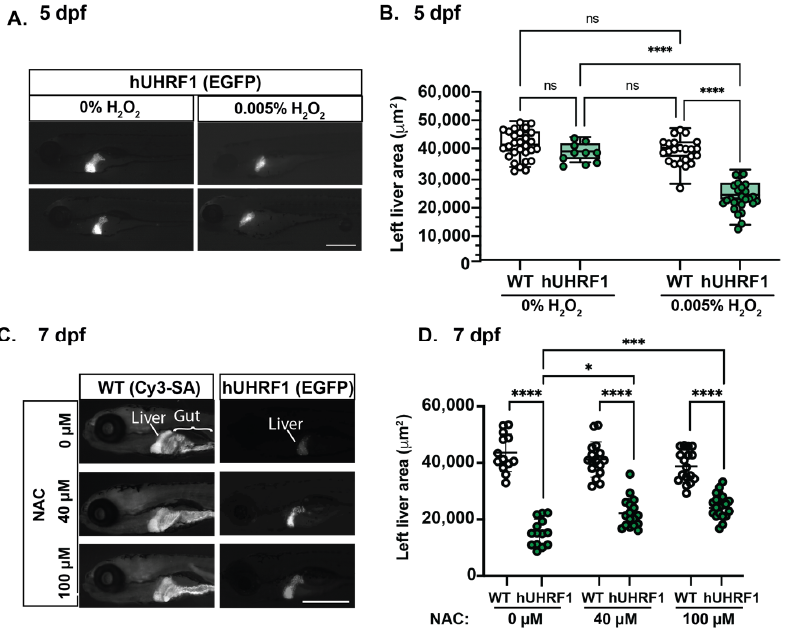
Figure 6. The small liver phenotype caused by hUHRF1 overexpression is enhanced by H 2 O 2 exposure and reversed by NAC treatment. ( A ) hUHRF1 transgenic larvae and their non-transgenic siblings were untreated or treated with 0.005% H 2 O 2 for 40–42 h and collected at 120 hpf. The left liver area was measured using the EGFP fluorescence (hUHRF1 transgenics) or CY3-SA staining (WT). ( B ) Left liver lobe area is significantly smaller in hUHRF1 larvae treated with 0.005% H 2 O